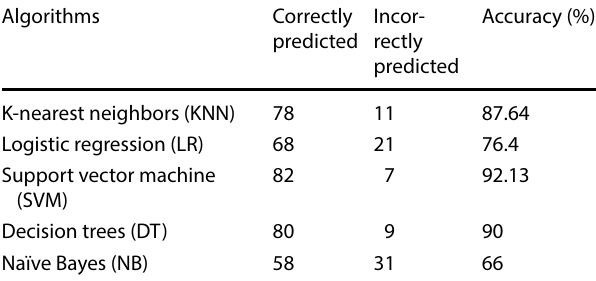
Table 8 Comparison of models on test data